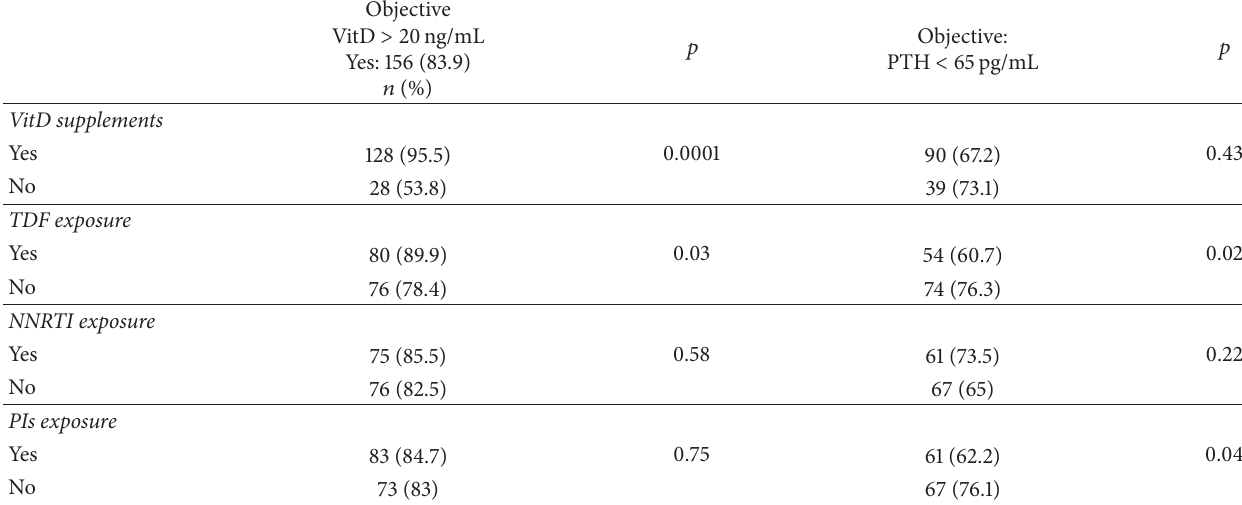
Table 5: Analysis patients with vitamin D < 20 ng/mL at